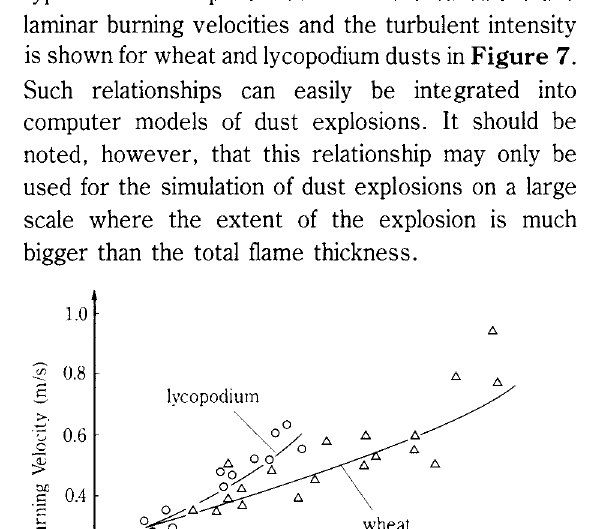
Fig. 6 Typical dependence of the laminar burning velocity of dust-air mixtures on dust concentration